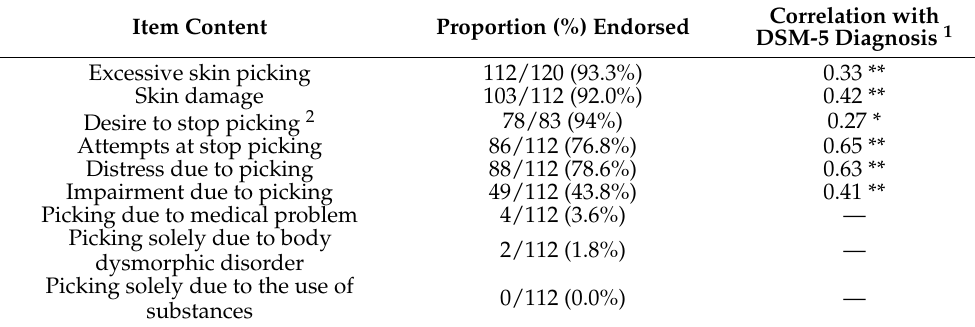
Table 2. Proportion of the sample that endorsed each of the diagnostic items and their correlation with full DSM-5 criteria. Item Content Proportion (%) Endorsed